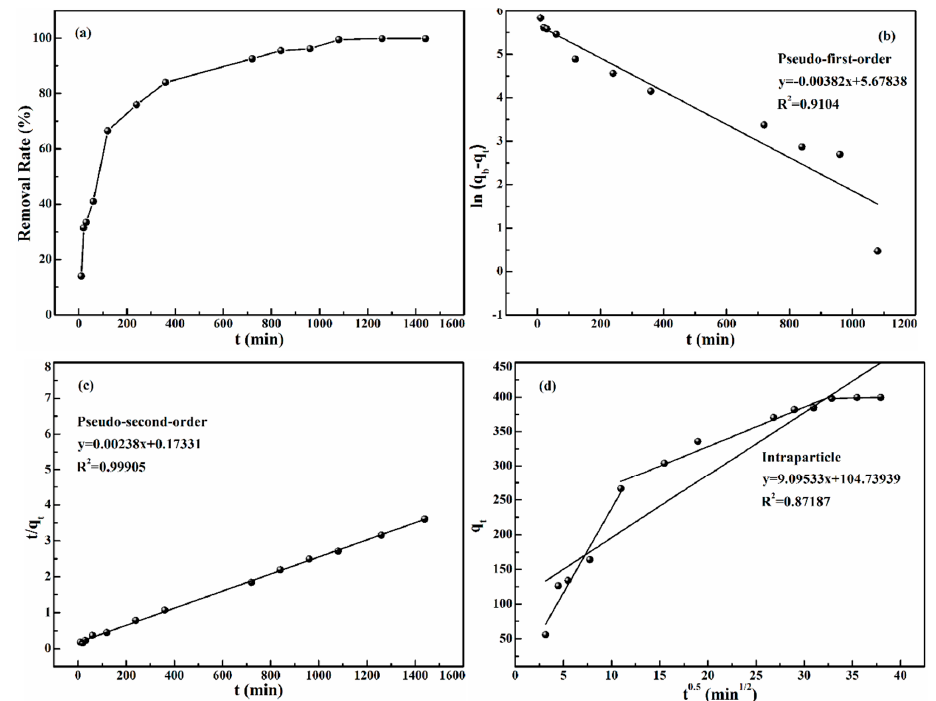
Figure 4. ( a ) Effect of the reaction time; ( b ) Pseudo-first-order model; ( c ) Pseudo-second-order model; ( d ) Intraparticle diffusion model. Table 1. The parameters of the pseudo-first-order and pseudo-second-order kinetic